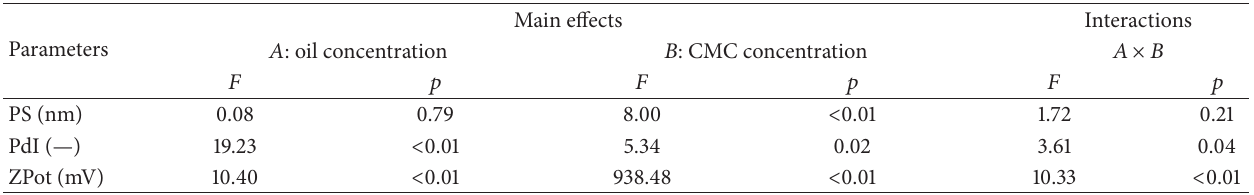
Table 1: Two-way ANOVA of particle size (PS), polydispersity index (PdI), and zeta potential (ZPot) for O/W nanoemulsions based on olive oil with different CMC concentrations. 𝐹 and 𝑝 values.